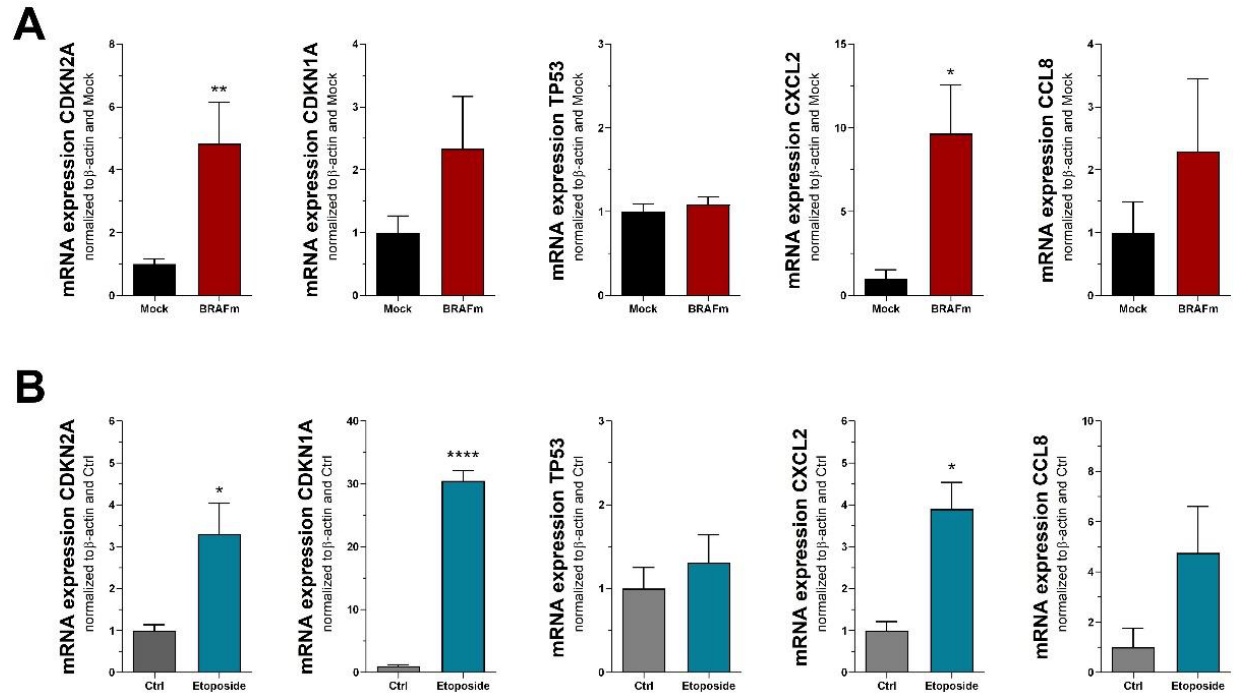
Figure 1. RNA markers of cellular senescence in ( A ) NHEM transduced with mutated BRAF V600E (n = 7) and ( B ) melanoma cell line Mel Juso treated with 100 µM etoposide (n = 3). Bars are shown as mean ± SEM (Student’s t -test). (*: p < 0.05, **: p < 0.01, ****: p < 0.0001).